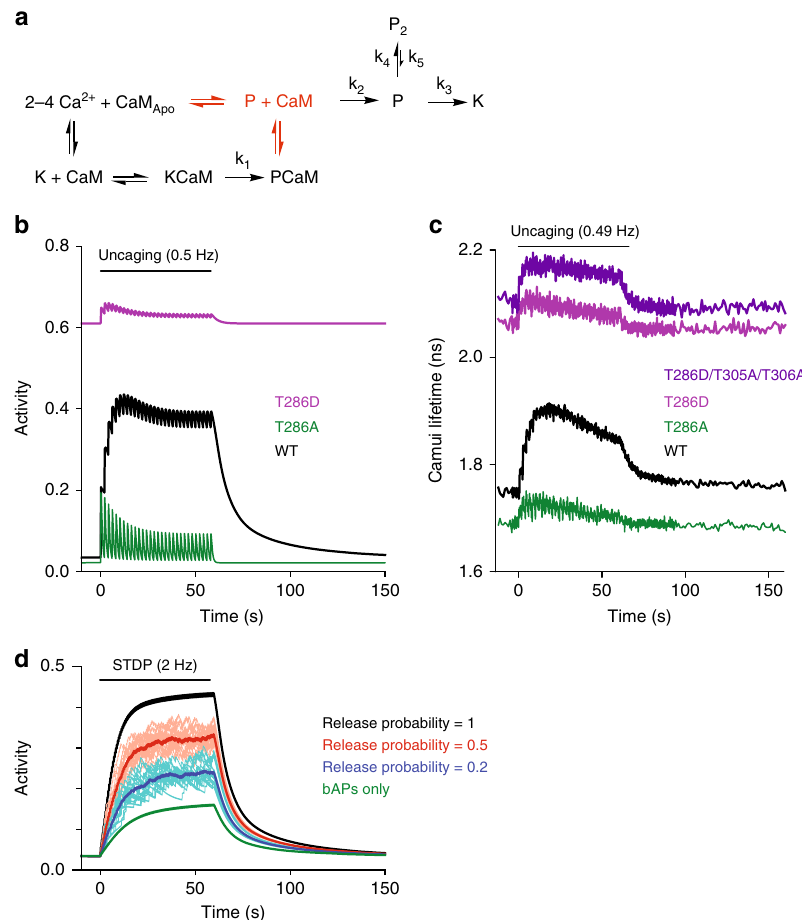
Fig. 7 Modi fi ed model of CaMKII α activation during spine plasticity induction. a Reaction scheme of CaMKII α activation that includes binding of CaM to phosphorylated CaMKII α (P state). The difference from Fig. 6b is highlighted in red. b Simulated activation of CaMKII α with mutations at T286 based on the proposed reaction scheme ( a ). Black: wildtype, green: T286A mutant, purple: T286D mutant, dark blue: T286D/T305A/T306A mutant. T305A/ T306A mutations are to prevent inhibition of CaM binding to T286D mutant by inhibitory T305/T306 phosphorylations 24 . c Activation of CaMKII α and its mutants in dendritic spines measured with Green-Camui α (data from ref. 10 ). d Simulated CaMKII α during a protocol to induce